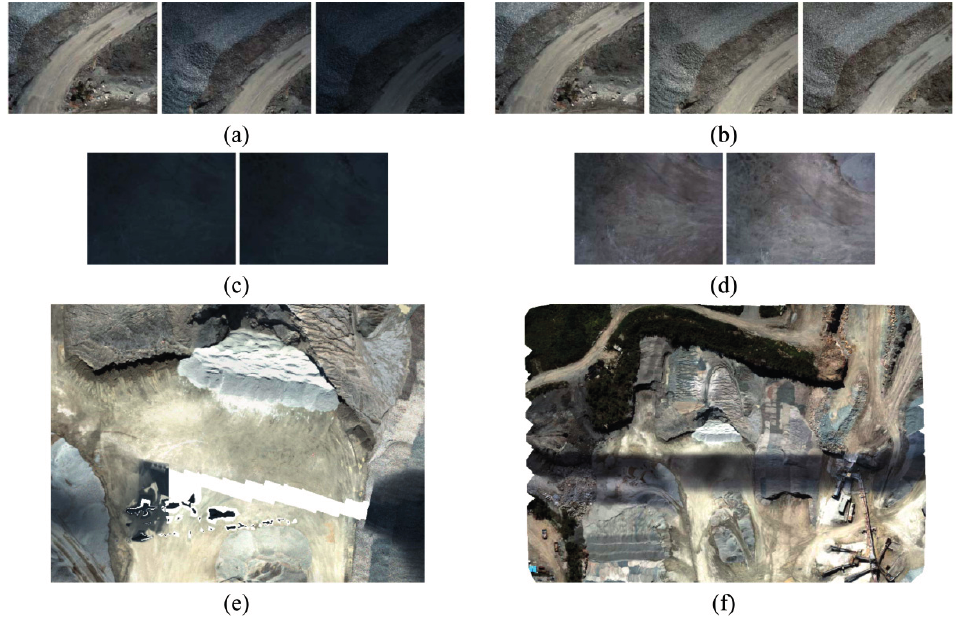
Figure 9. Intensity enhancement ( a ) A sequence of illuminated and dark images; ( b ) Images of Figure 9a after correction; ( c ) Two adjacent dark images with low texture diversity; ( d ) Images of Figure 9c after correction; ( e ) Failure in ortho-mosaic generation; ( f ) Correct mosaic after intensity